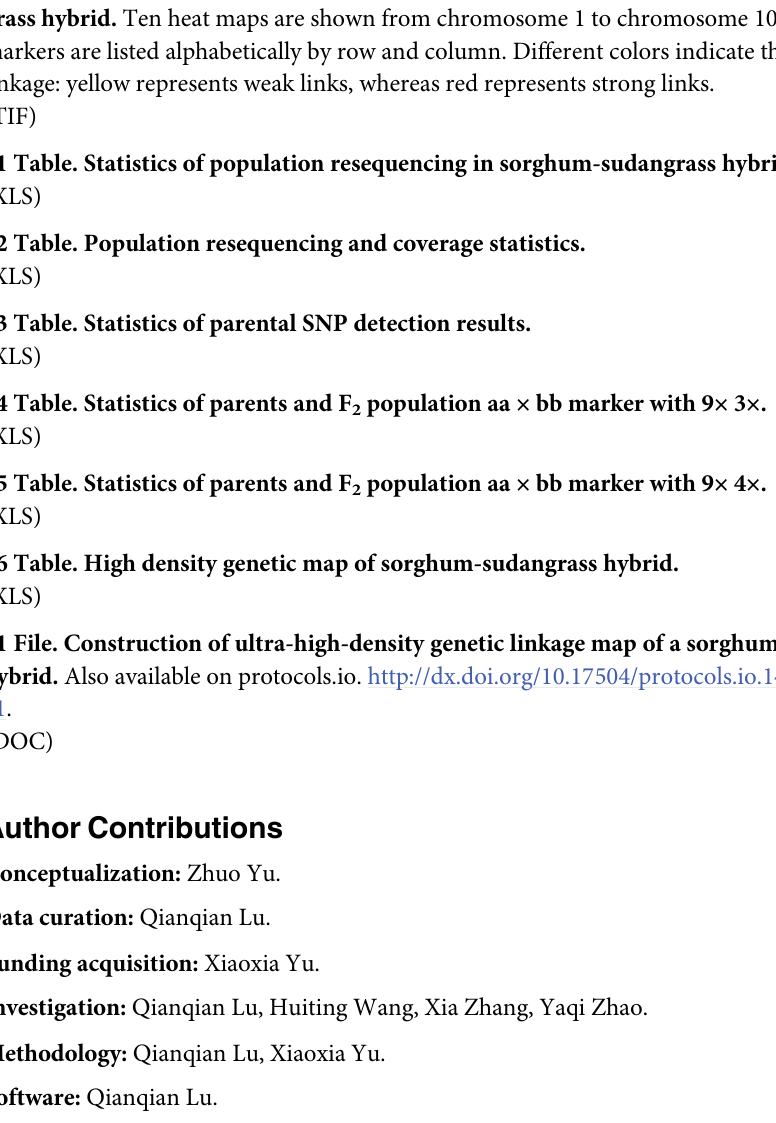
S1 Fig. Haplotype maps for 10 linkage groups of the sorghum-sudangrass hybrid. From chromosomes 1 to 10, ten haplotype maps represent an individual’s genotype. Each row of numbers on the left represents a sample number. The horizontal axis represents the tag name. There are two chromatids from each parent in green and blue; missing data are shown in red and heterozygosity in purple. S2 Fig. Heat maps for 10 linkage groups of the density genetic map for the sorghum-sudan- grass hybrid. Ten heat maps are shown from chromosome 1 to chromosome 10, in which markers are listed alphabetically by row and column. Different colors indicate the strength of linkage: yellow represents weak links, whereas red represents strong links. S1 Table. Statistics of population resequencing in sorghum-sudangrass hybrid. S2 Table. Population resequencing and coverage statistics. S3 Table. Statistics of parental SNP detection results. S4 Table. Statistics of parents and F population aa × bb marker with 9 × 3 × . 2 S5 Table. Statistics of parents and F population aa × bb marker with 9 × 4 × . 2 S6 Table. High density genetic map of sorghum-sudangrass